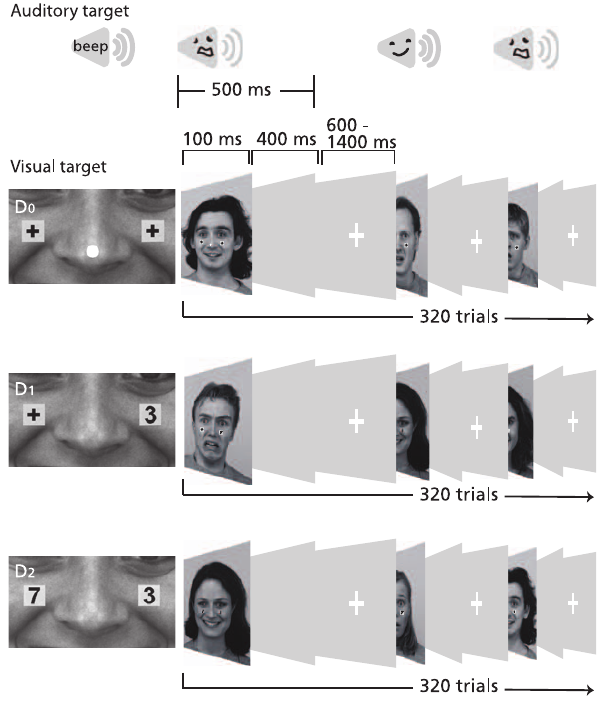
Figure 1. Layout of the task. Attention was manipulated between AV blocks, and participants had to respond to a visual dot and auditory beep (D 0 ), a single digit ‘3’ (D 1 ), or when two digits together add up to 10 (D 2 ). Stimuli were presented concurrently during AV blocks and in isolation during unisensory